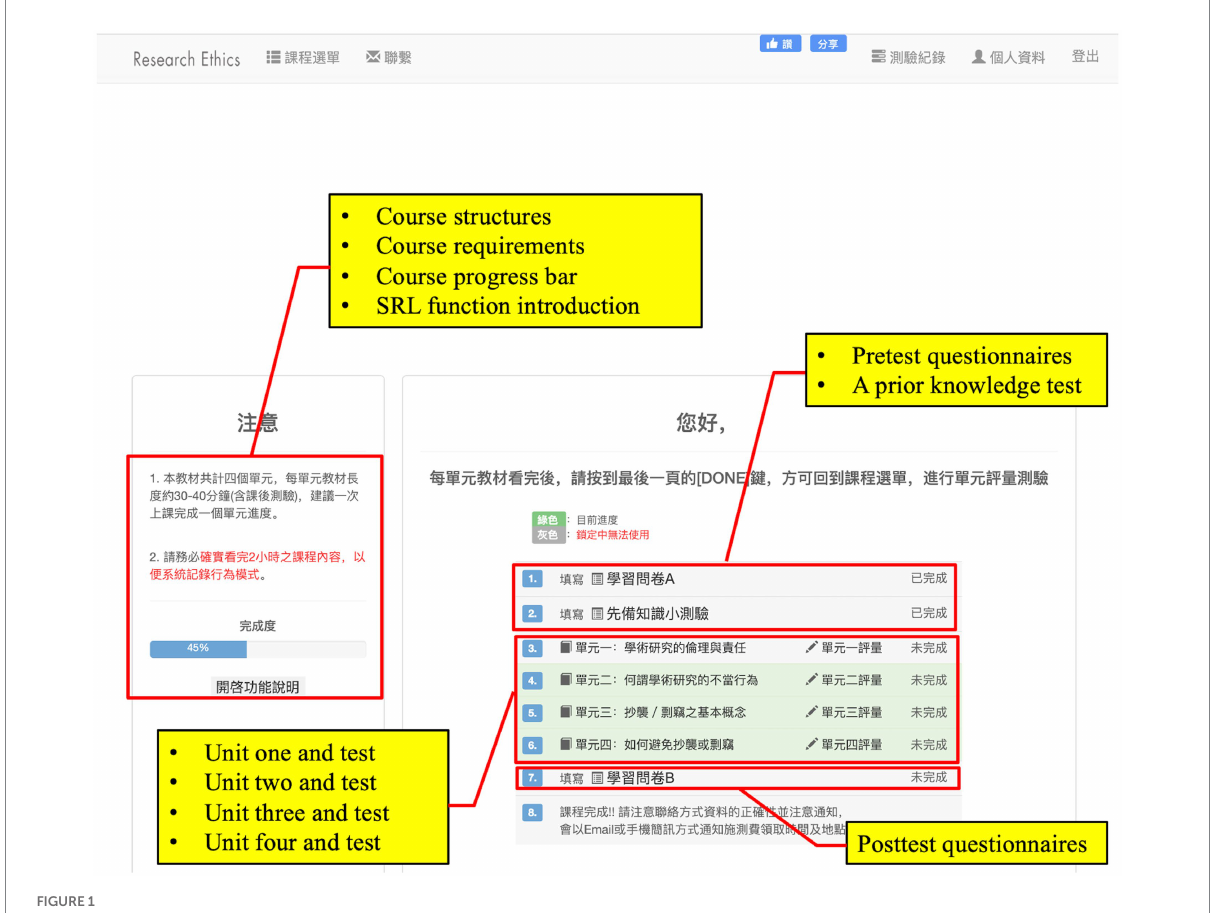
FIGURE 1 The user interface for unit selection and test